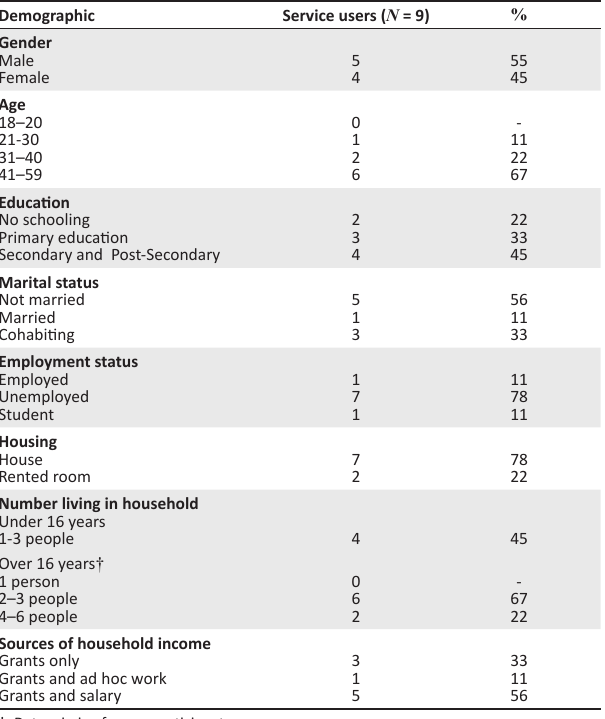
TABLE 1: Demographic characteristics of service users interviewed.